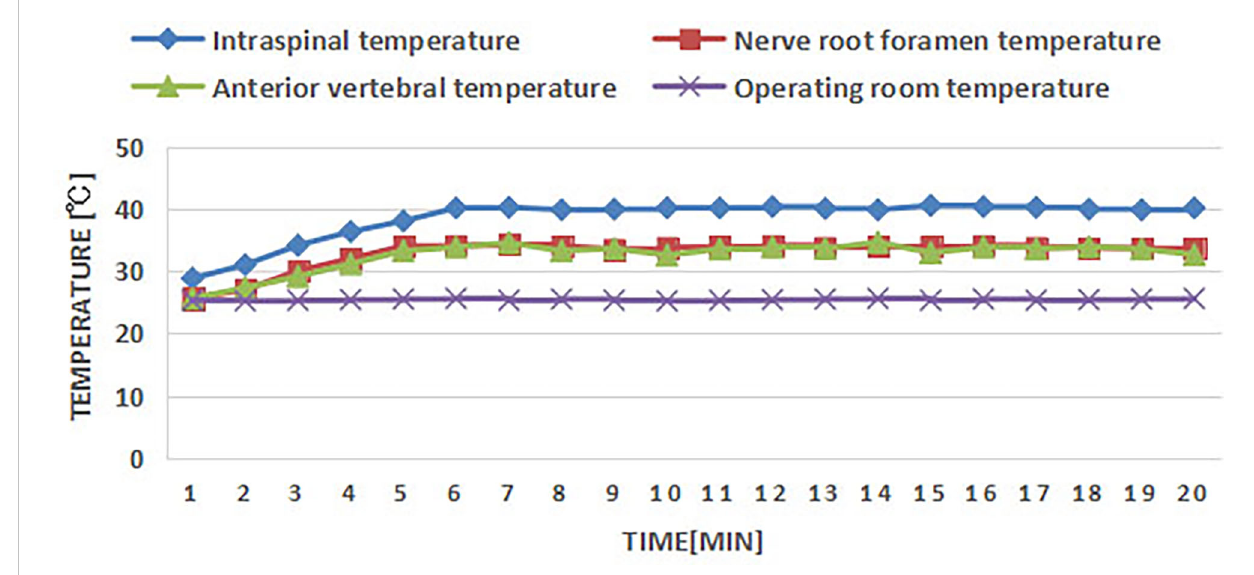
FIGURE 7 Temperature measurement points in spinal canal, nerve root foramen, and anterior edge of